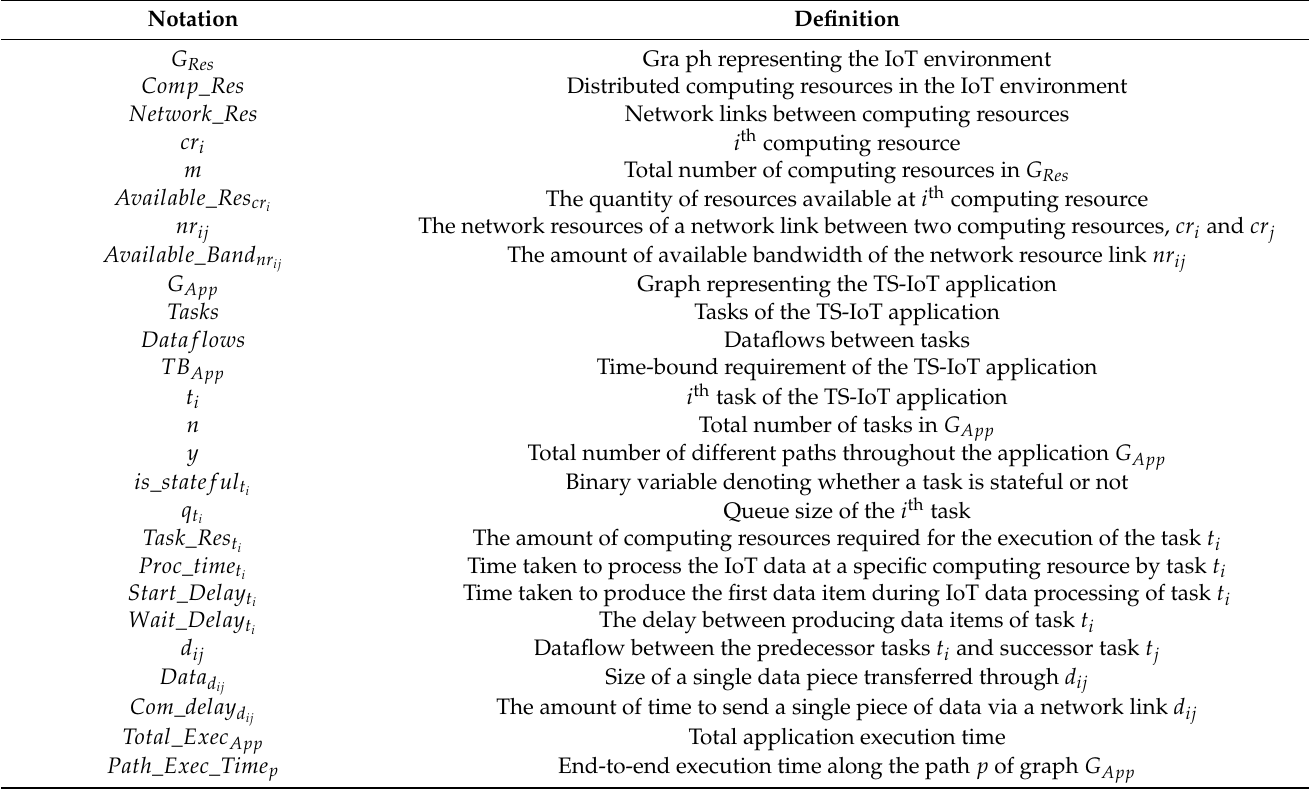
Table 1. Notations used in the system model and problem